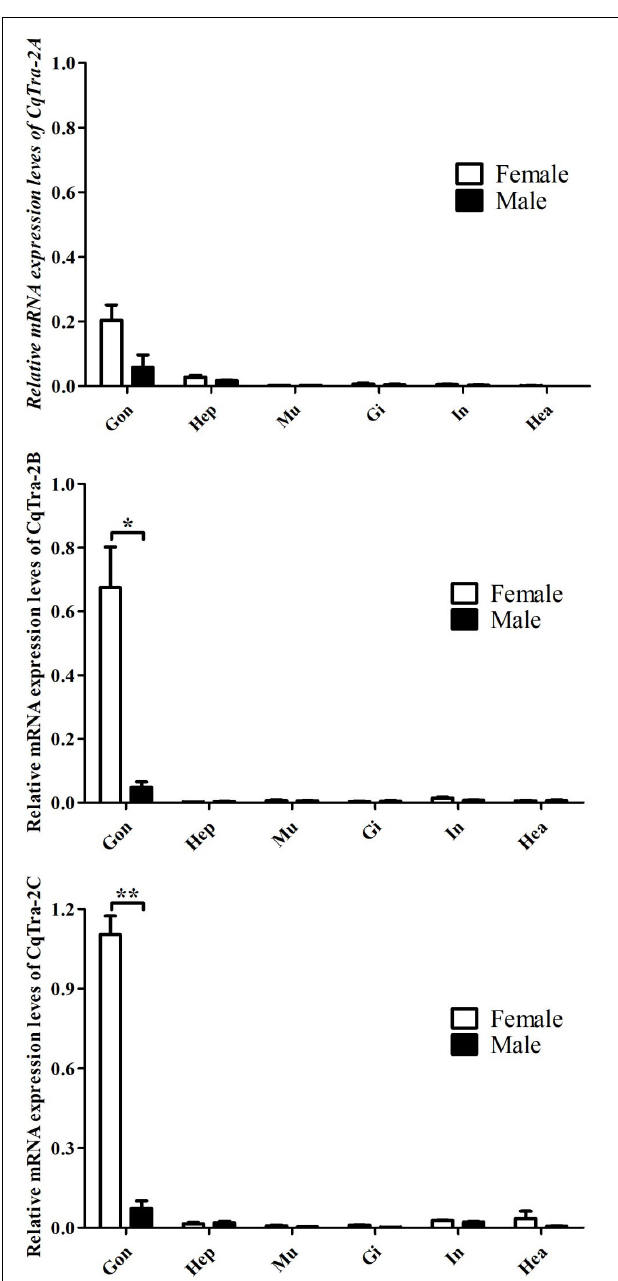
FIGURE 3 | Distribution of three CqTra-2 isoforms in various tissues from C. quadricarinatus. The 18S-rRNA gene is used as control. Gon, gonads (Ovary and Testis, respectively); Hep, hepatopancreas; Mu, muscle; Gi, Gill; In, intestine; Hea, heart. Results are expressed as mean ± SEM, and significance of comparison is defined as P < 0.05 (*) or P < 0.01 (**) by Student’s t -tests.